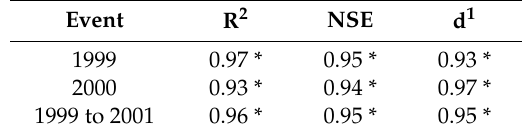
Table 2. Statistical evaluation of modeled simulations during the calibration period